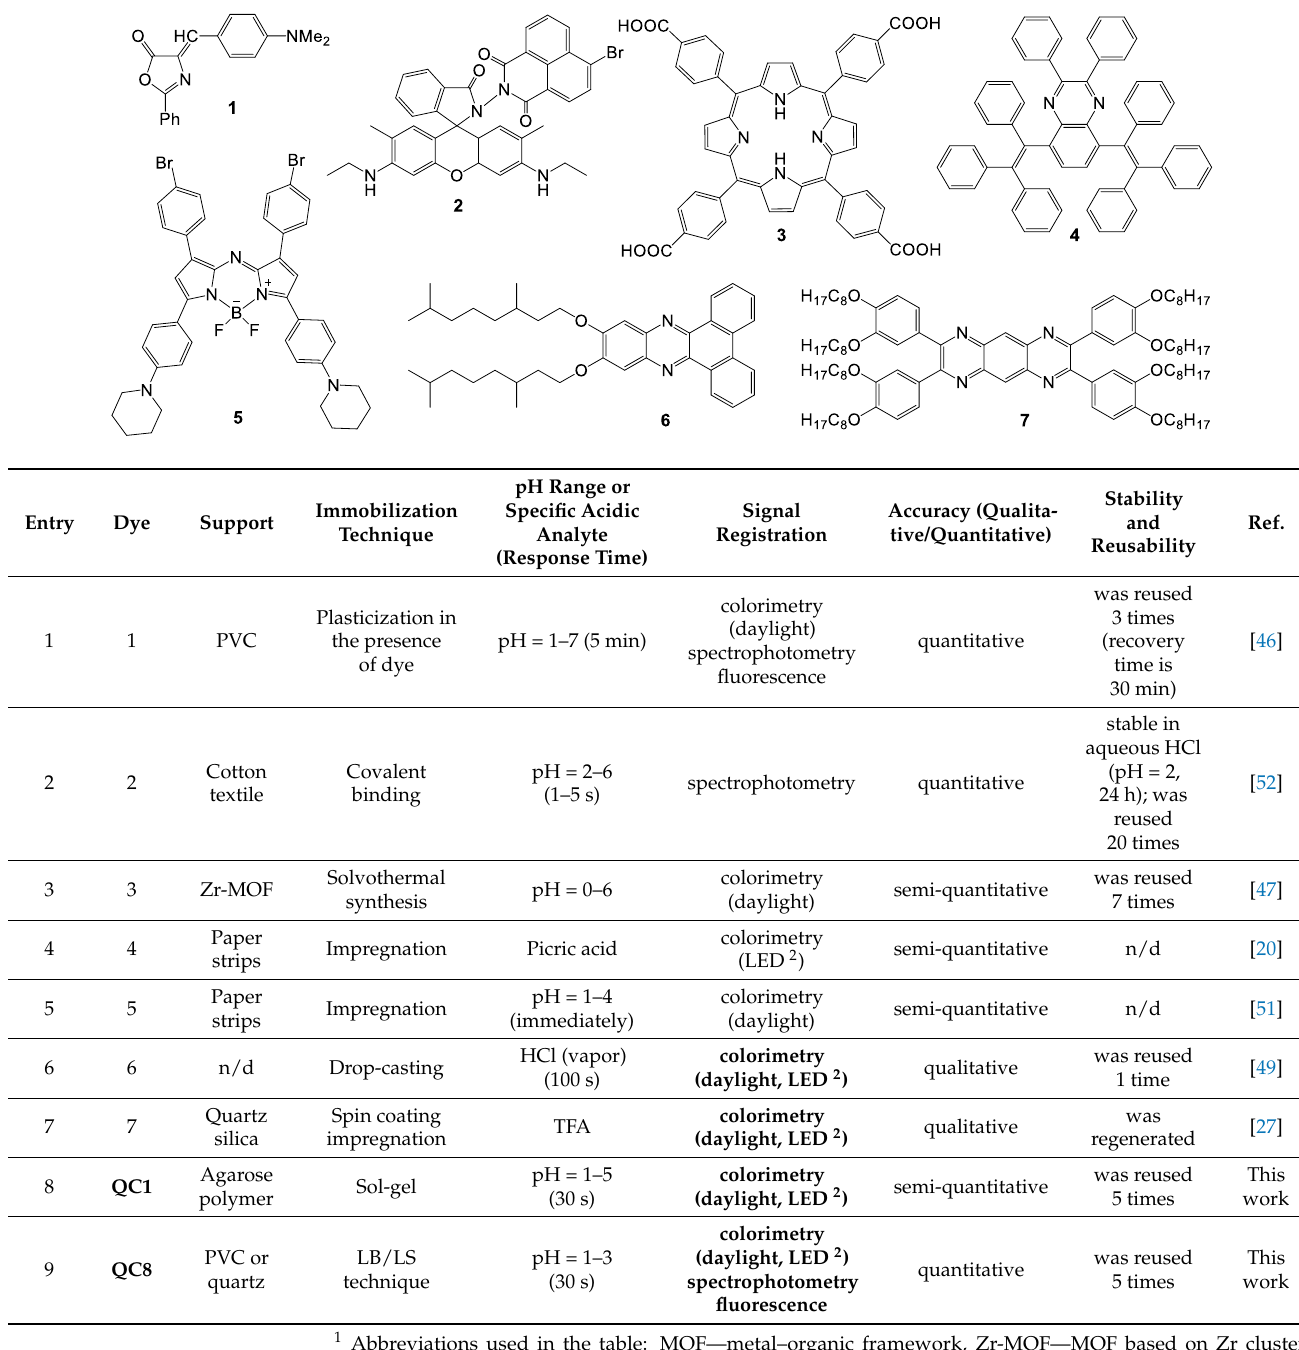
Table 1. Selected halochromic materials for pH measurements in the range of 1 – 6 1 .